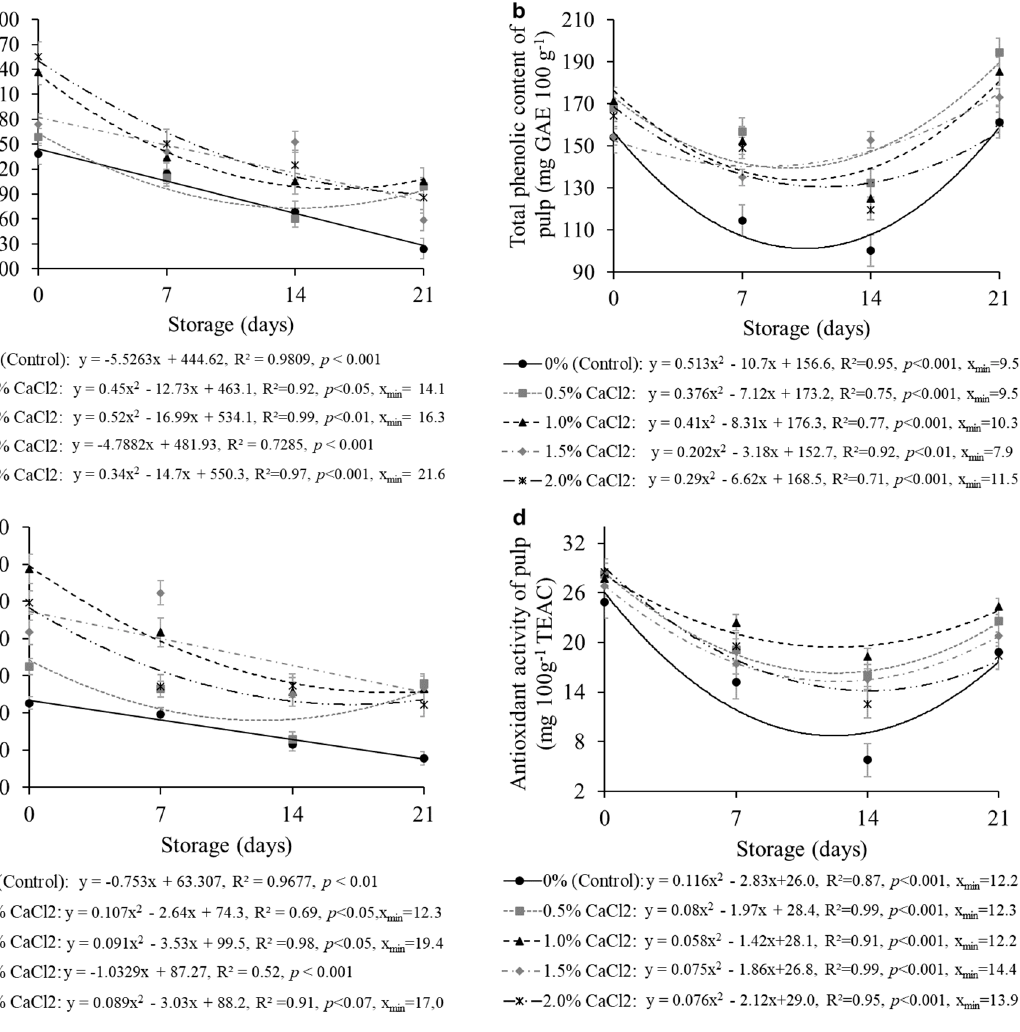
Figure 7. Total phenolic content of peel ( a ) and pulp ( b ) and antioxidant activity of peel ( c ) and pulp ( d ) of ‘Roxo de Valinhos’ fig fruits as a function of CaCl 2 concentrations and storage days at 5 ± 1 °C and 90–95% R.H. Bars symbolise standard errors (n = 4).